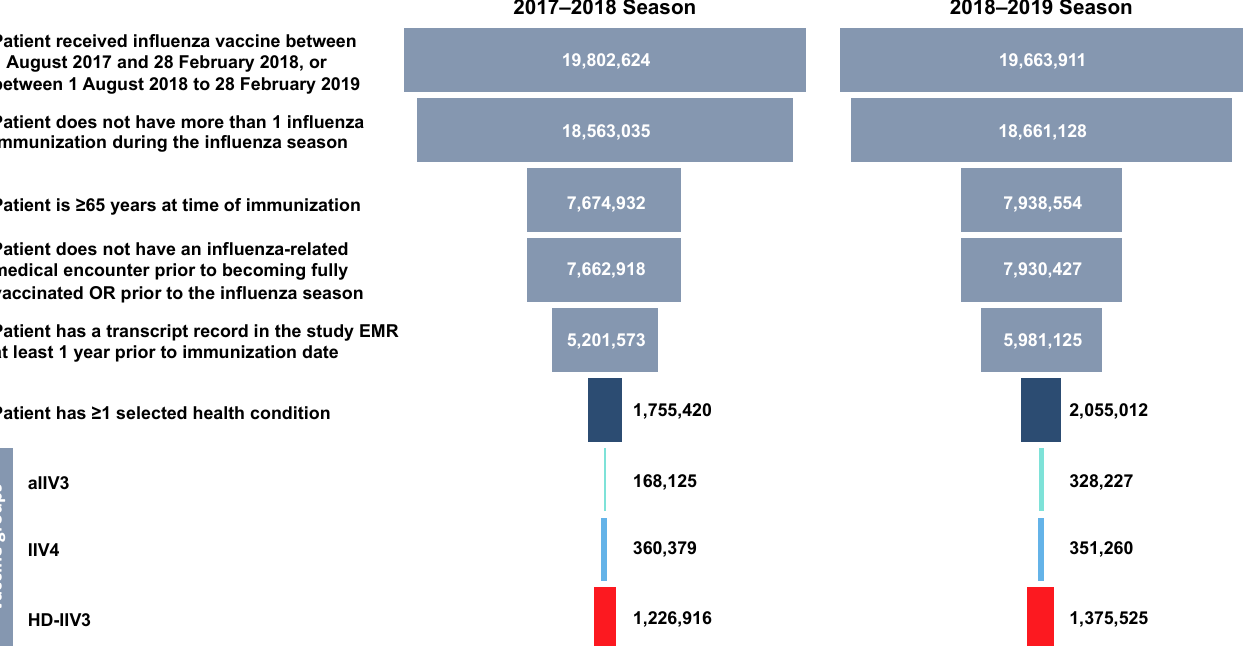
Table 1. Subject demographics at baseline.